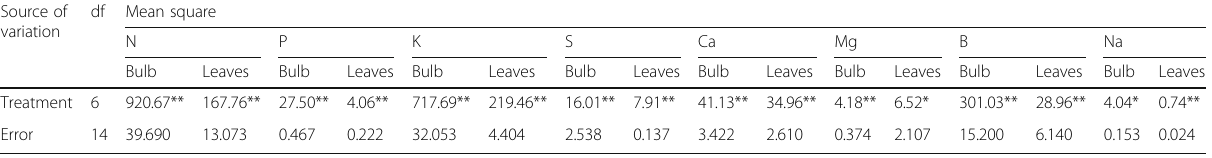
Table 10 Analysis of variance of N, P, K, S, Ca, Mg, B and Na uptake of